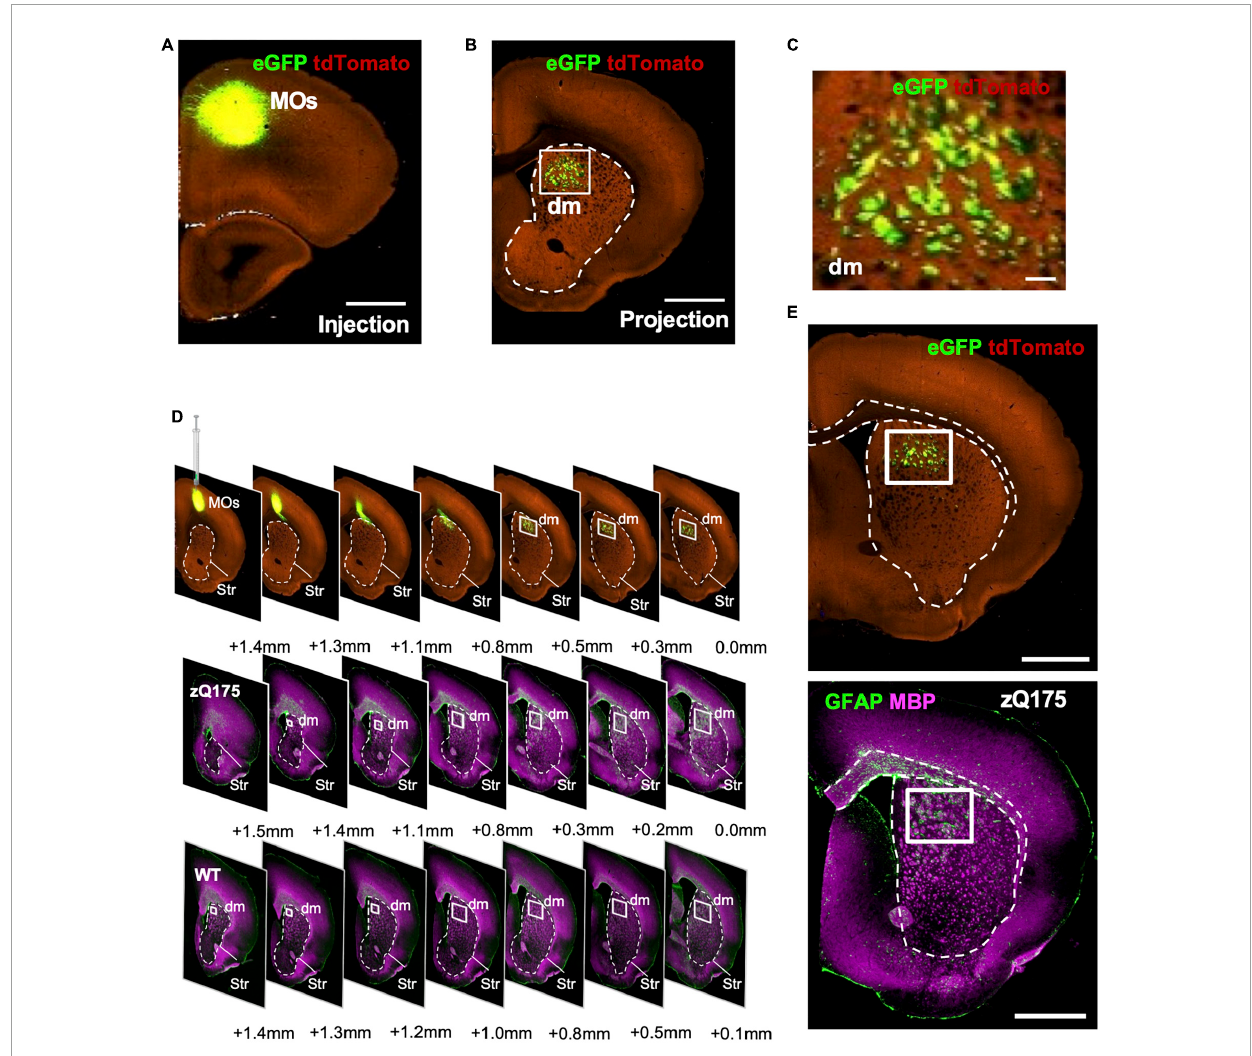
FIGURE7 Motor area (MOs) WM fascicles project into the dm striatum and accumulate in areas with enhanced GFAP + clusters. eGFP tracing in Syt6-Cre-TdTomato mice showing MOs injection location (A) and projections through the dm striatum (B) from Allen Mouse Brain Connectivity Atlas: connectivity.brain-map.org/projection/experiment/177459319. (C) Zoomed images from the dm regions of the striatum boxed in (B) . Comparison of serial coronal sections (D) or brain bregma + 3.5 mm (E) for MOs-eGFP injected Syt6-Cre-TdTomato mice, and 18-month-old zQ175 immunostained with GFAP and MBP. WT mice are used as reference. Striatum is highlighted with a dotted line and dm striatum is denoted with a white box. Serial coronal sections for MOs-eGFP injected Syt6-Cre mice in G were obtained from the Allen Mouse Brain Connectivity Atlas: connectivity.brain-map.org/projection/experiment/122642490. Scale bar is 1